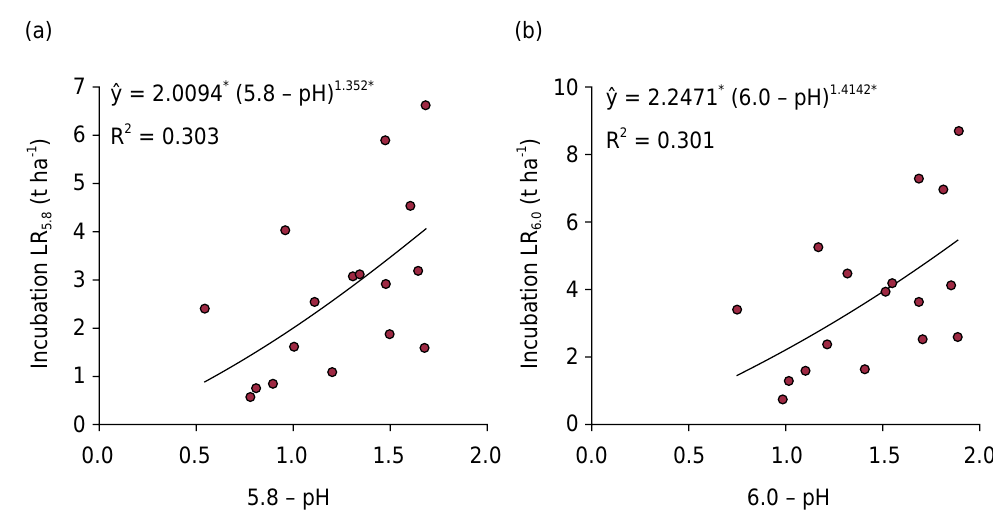
Figure 3. Relationships between lime requirement (LR) determined from the 60 d incubation to target pH values of 5.8 (a) or 6.0 (b) and changes in soil pH (target pH - initial pH). *: p<0.05.